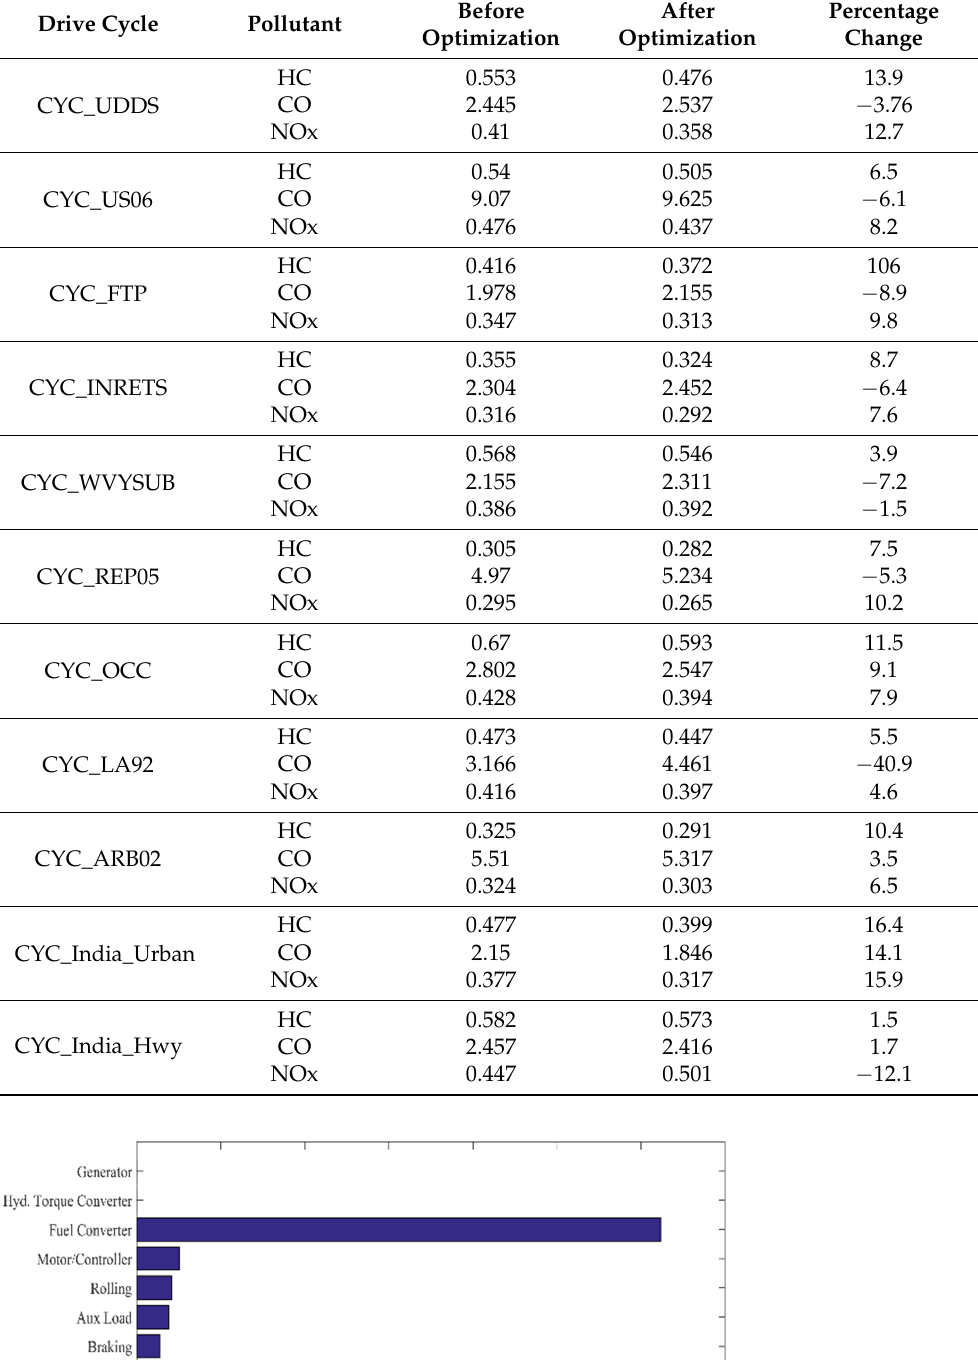
Table 7. Pollutant emission comparison.